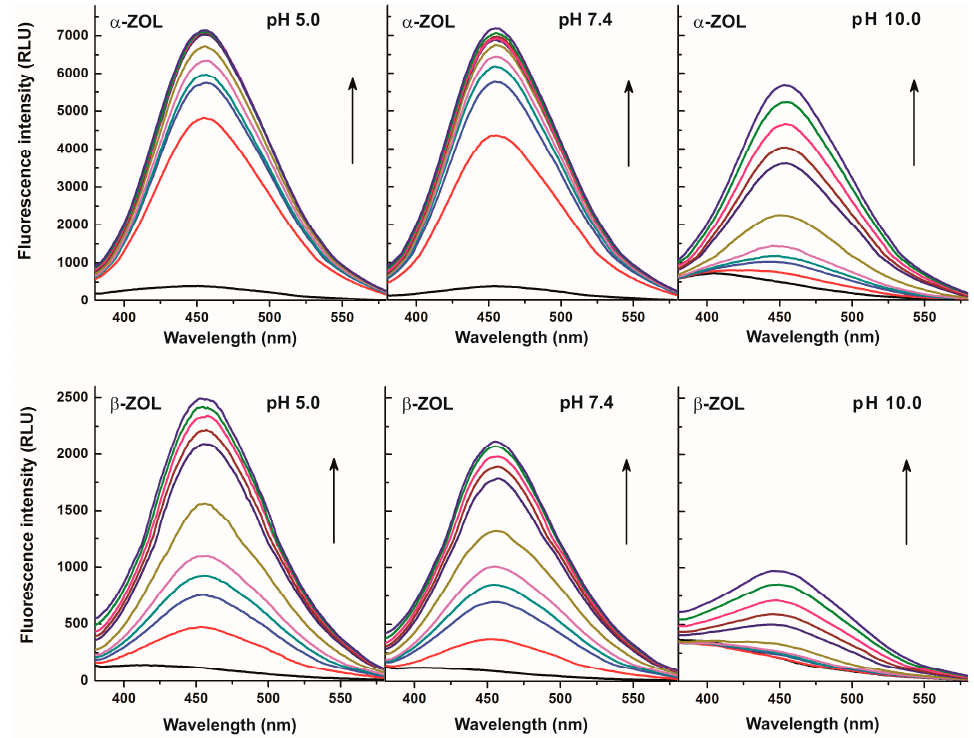
Figure 3. Fluorescence emission spectra of α -ZOL (2 µ M; top ) and β -ZOL (2 µ M; bottom ) in the presence of increasing concentrations of DIMEB (0 mM: black, 0.02 mM: red, 0.05 mM: blue, 0.07 mM: dark cyan, 0.1 mM: magenta, 0.2 mM: dark yellow, 0.5 mM: purple, 0.7 mM: brown, 1.0 mM: pink, 1.5 mM: green, 2 mM: dark blue) in 0.05 M sodium acetate (pH 5.0; left), PBS (pH 7.4; middle ), and 0.05 M sodium borate (pH 10.0; right ) buffers ( λ exc = 315 nm).